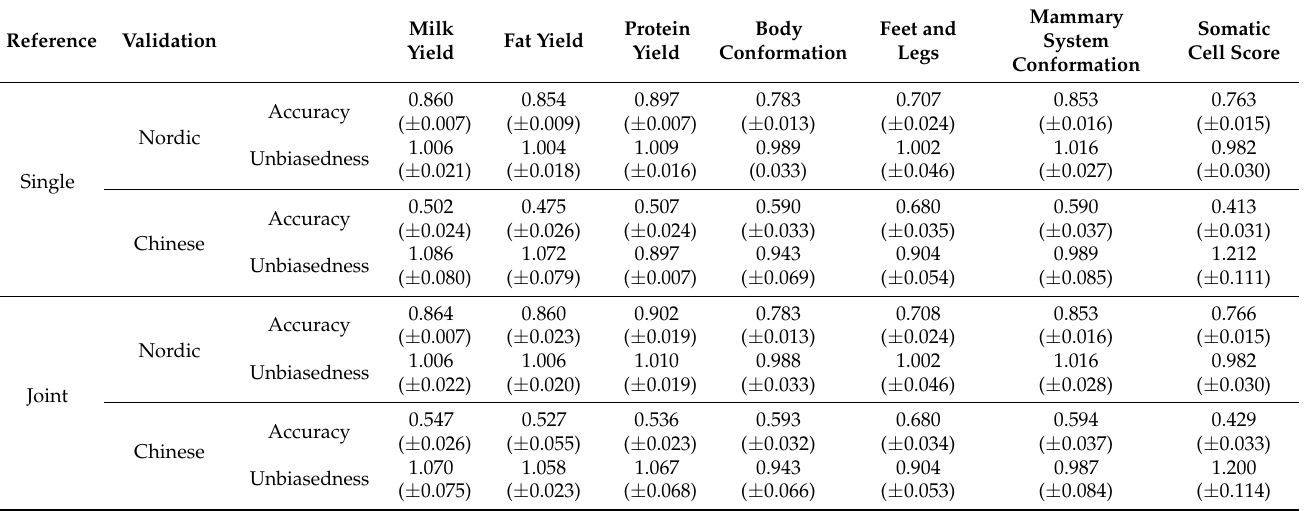
Table 4. Prediction accuracy and unbiasedness regarding the seven traits in the Chinese and Nordic Holstein populations, as predicted by the single/joint reference populations in the 10 replicates of the five-fold cross-validation.